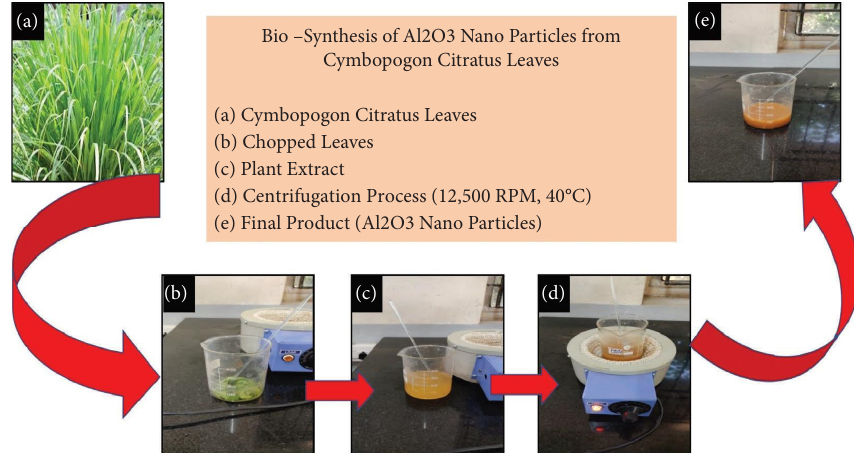
Table 1: Parameter design of biosynthesised jute/hemp/epoxy composites. Sl. no Groups Combinations